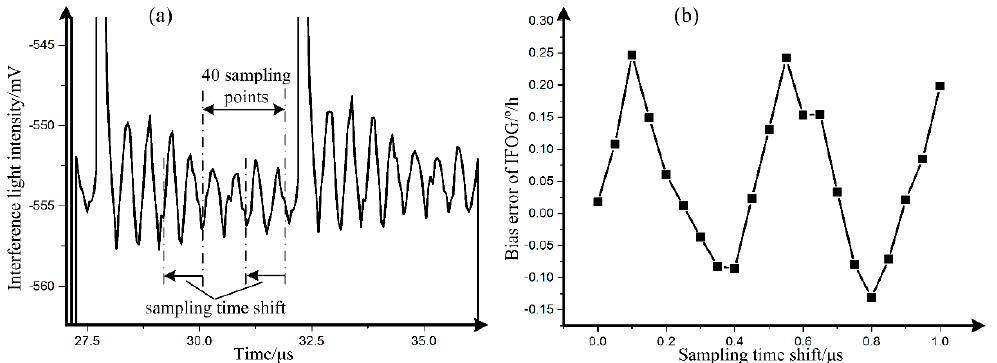
Figure 8. ( a ) Schematic diagram of sampling points; ( b ) measured results between the bias error of IFOG and sampling time shift.